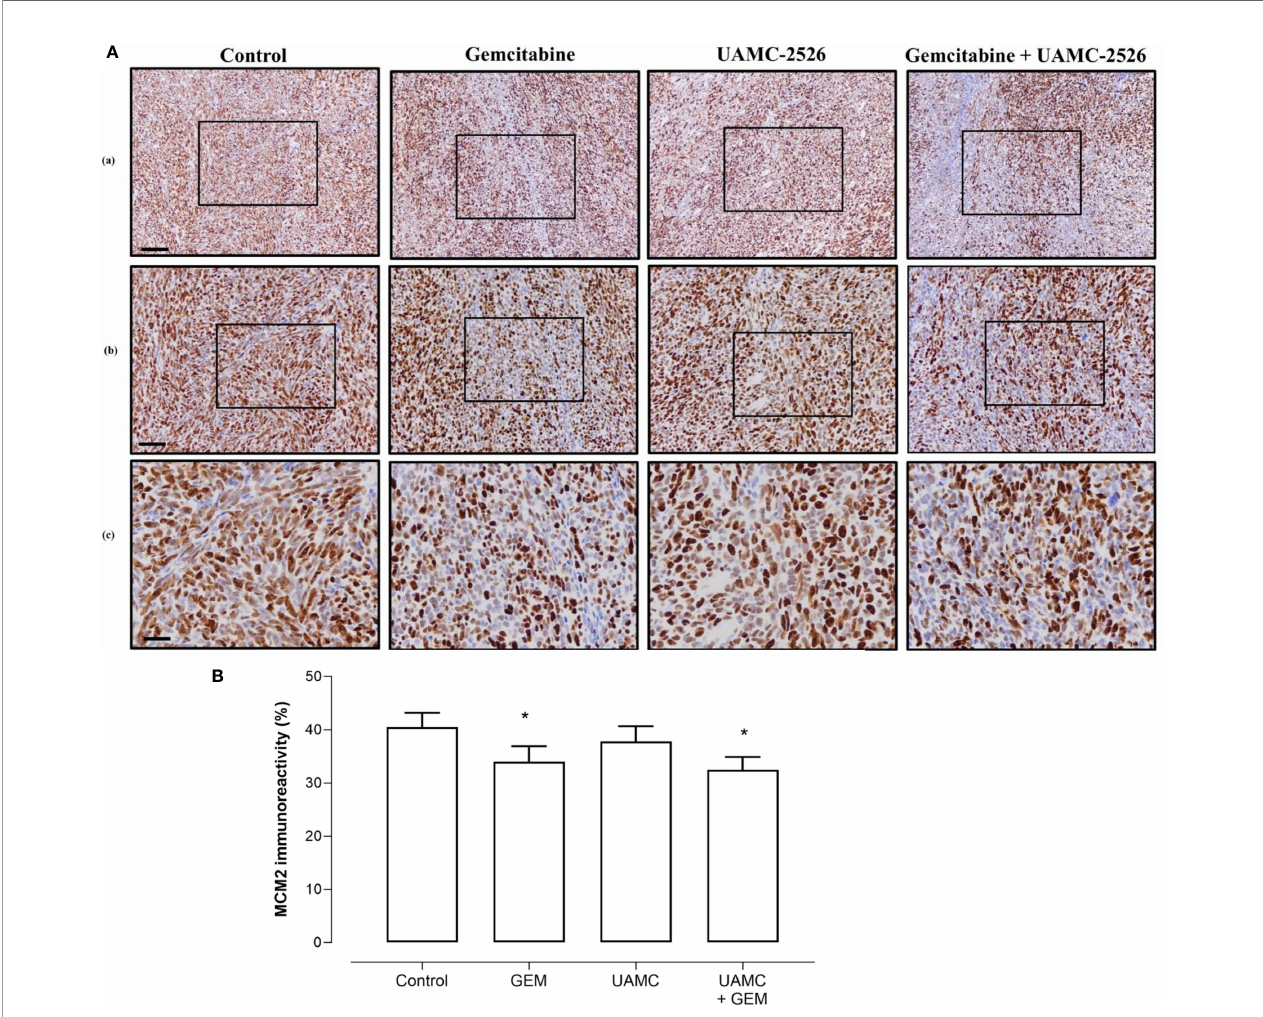
FIGURE 7 | Immunohistochemical analysis of cell proliferation marker MCM2 in Panc02 tumors. (A) C57/BL6 mice with Panc02 tumors were treated with vehicle (control), UAMC-2526 (UAMC), gemcitabine (GEM) or a combination of UAMC-2526 and gemcitabine. After treatment, tissue sections of Panc02 tumors were immunostained with MCM2 antibodies. Scale bar = 100 µm (a), 50 µm (b), 20 µm (c). (B) Quanti fi cation of MCM2 immunoreactivity. Number of animals in each group was between 8-10. Data were analyzed with factorial analysis of variance (ANOVA), *p ≤ 0.05 with factors GEM (p=0.041) and UAMC (p=0.452), interaction GEM by UAMC